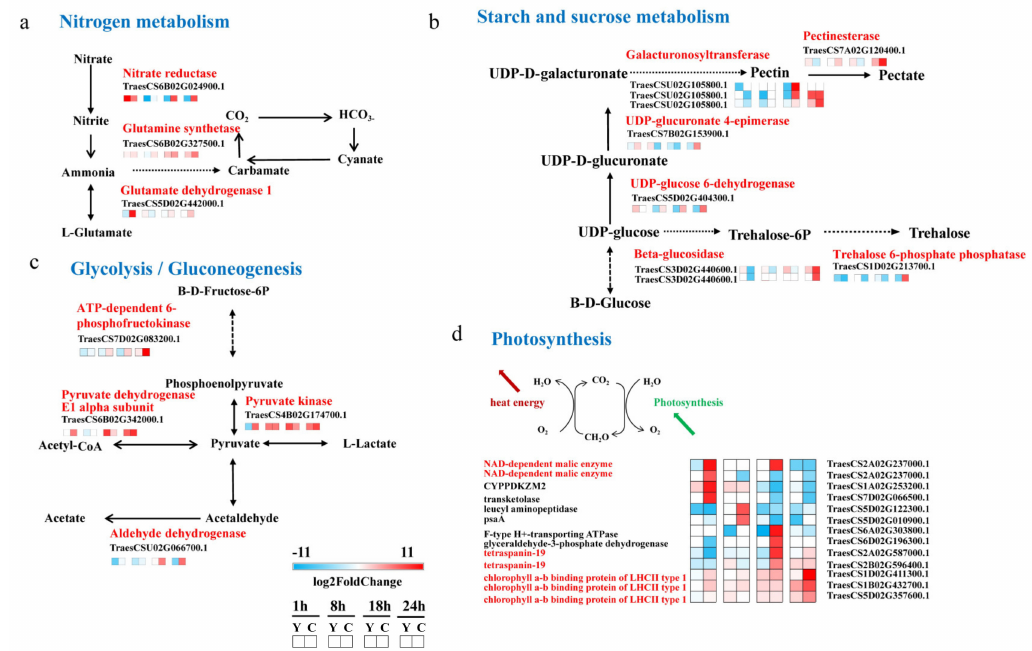
Figure 6. CMPG1-V OE and Yangmai 158 DEGs related to four energy metabolic signaling pathways. ( a ) Nitrogen metabolism; ( b ) starch and sucrose metabolism; ( c ) glycolysis / gluconeogenesis; ( d ) photosynthesis. Heat map showing the gene expression. The colors blue, white, and red represent low, medium, and high expression levels, respectively. Y represents Yangmai 158, C represents CMPG1-V OE . Genes with the regulation ratio log ≥ 2 or ≤− 2 were